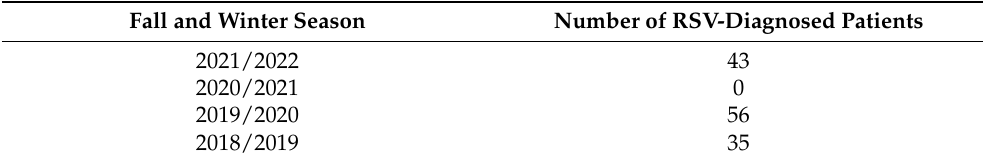
Table 2. Number of patients with RSV infection hospitalized in the fall and winter seasons of